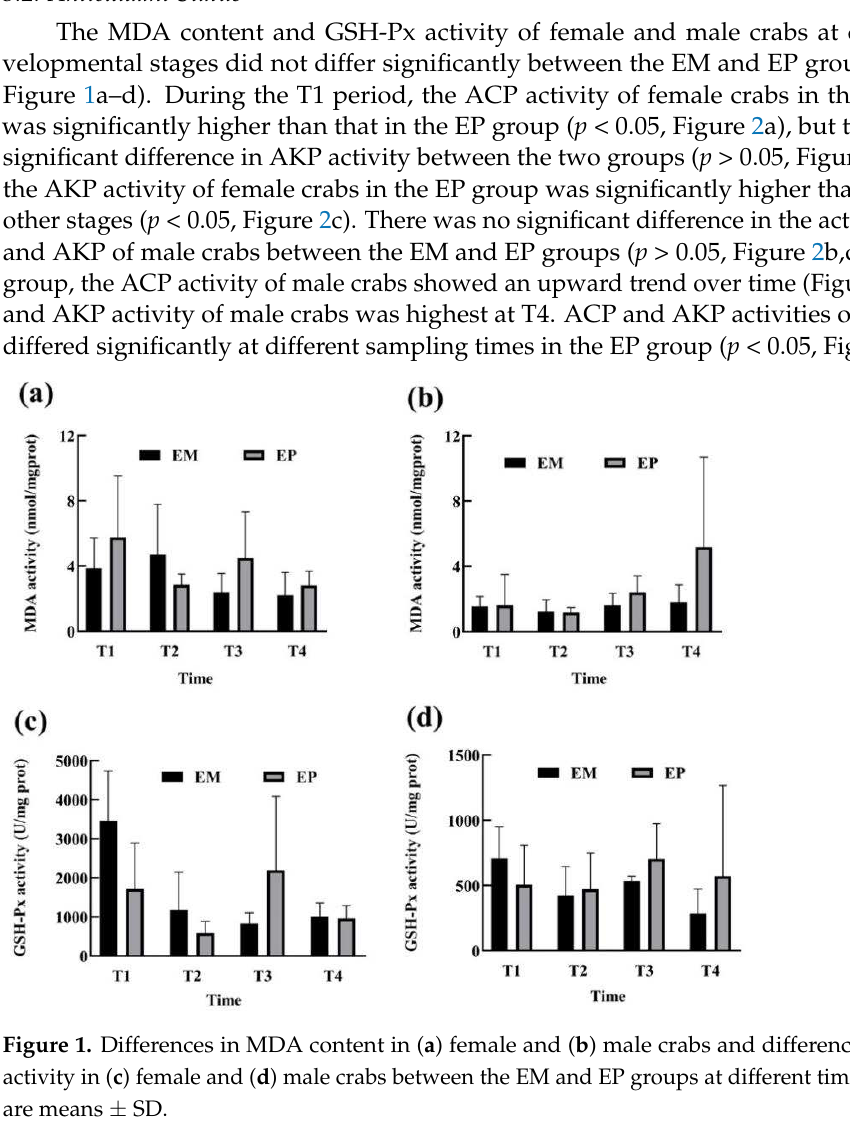
Figure 2. Differences in activities of ACP in ( a ) female and ( b ) male crabs and differences in AKP activity in ( c ) female and ( d ) male crabs between the EM and EP groups at different time points. Data are means ± SD. * indicates a statistically significant difference between the EM and EP groups at T1. Different lowercase letters indicate significant differences among different time points in the same group ( p < 0.05).